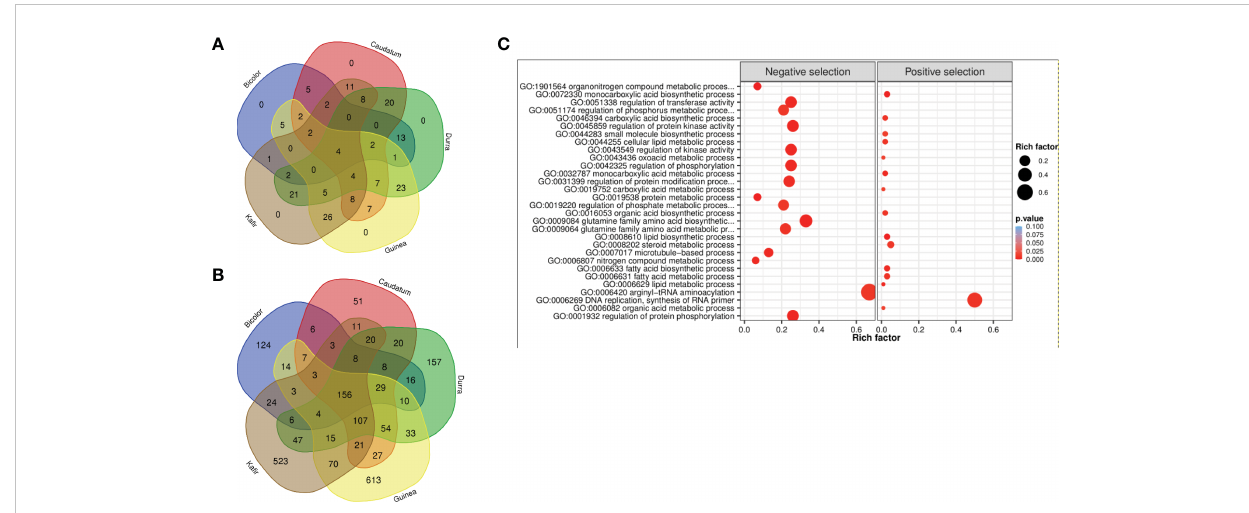
FIGURE 5 Venn diagram of (A) positive selection and (B) negative selection genes from fi ve sorghum races combinations. (C) Signi fi cantly enriched GO biological terms for positive and negative selected genes (bubble color indicates the p-value range and size indicates the gene